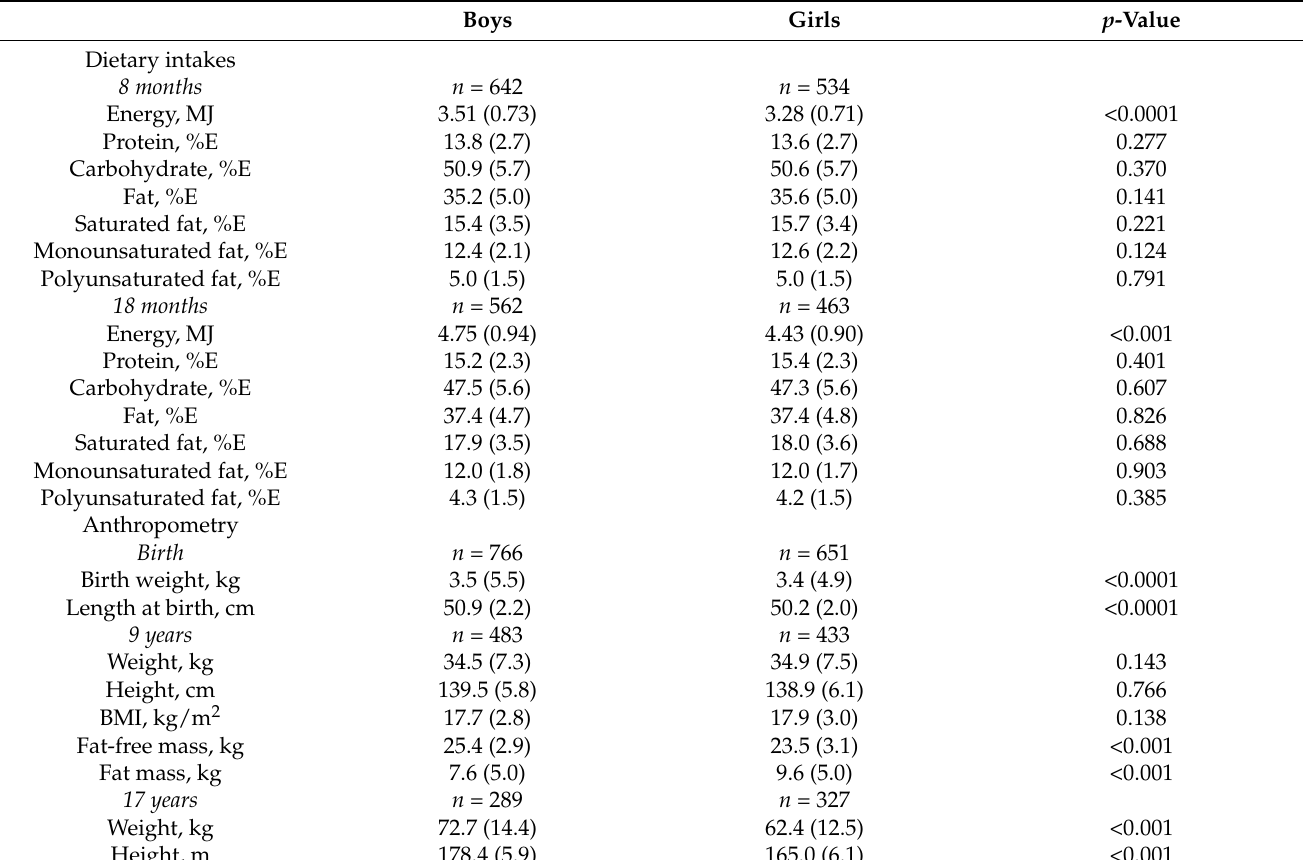
Table 1. Descriptive statistics for nutrient intakes at 8 months and 18 months and body composition at birth, 9 and 17 years in boys and girls enrolled in Avon Longitudinal Study of Parents and Children (ALSPAC)-Children in Focus